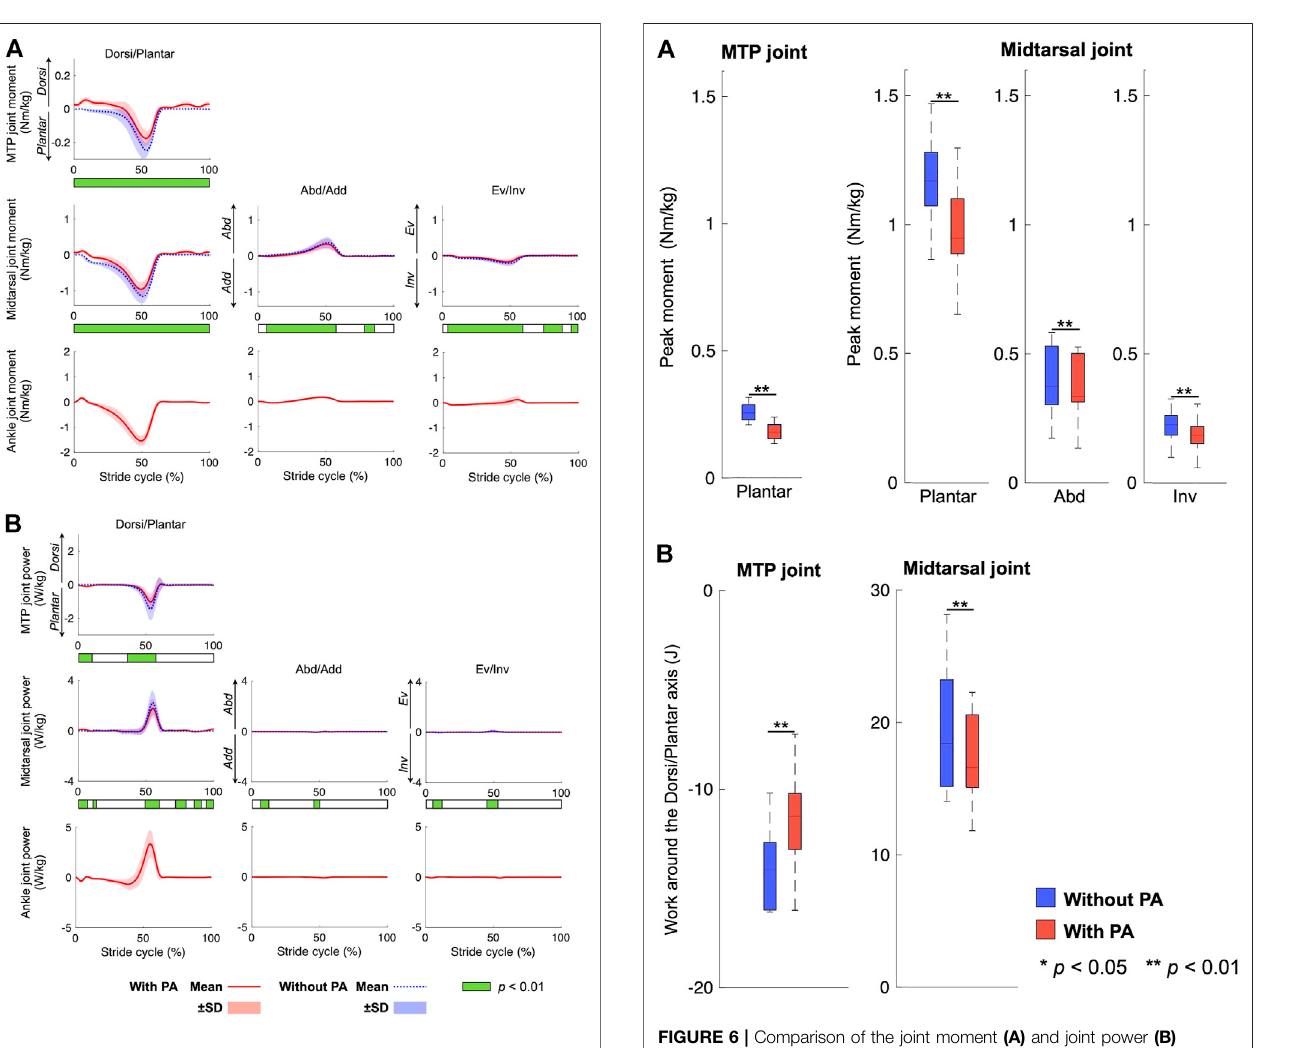
FIGURE 5 | Mean joint moment (A) and joint power (B) pro fi les during walking. Mean (solid red line = with PA, dotted blue line = without PA) ± standard deviation (red and blue bands, respectively). Color bar below each graph shows the results of the SPM analysis.